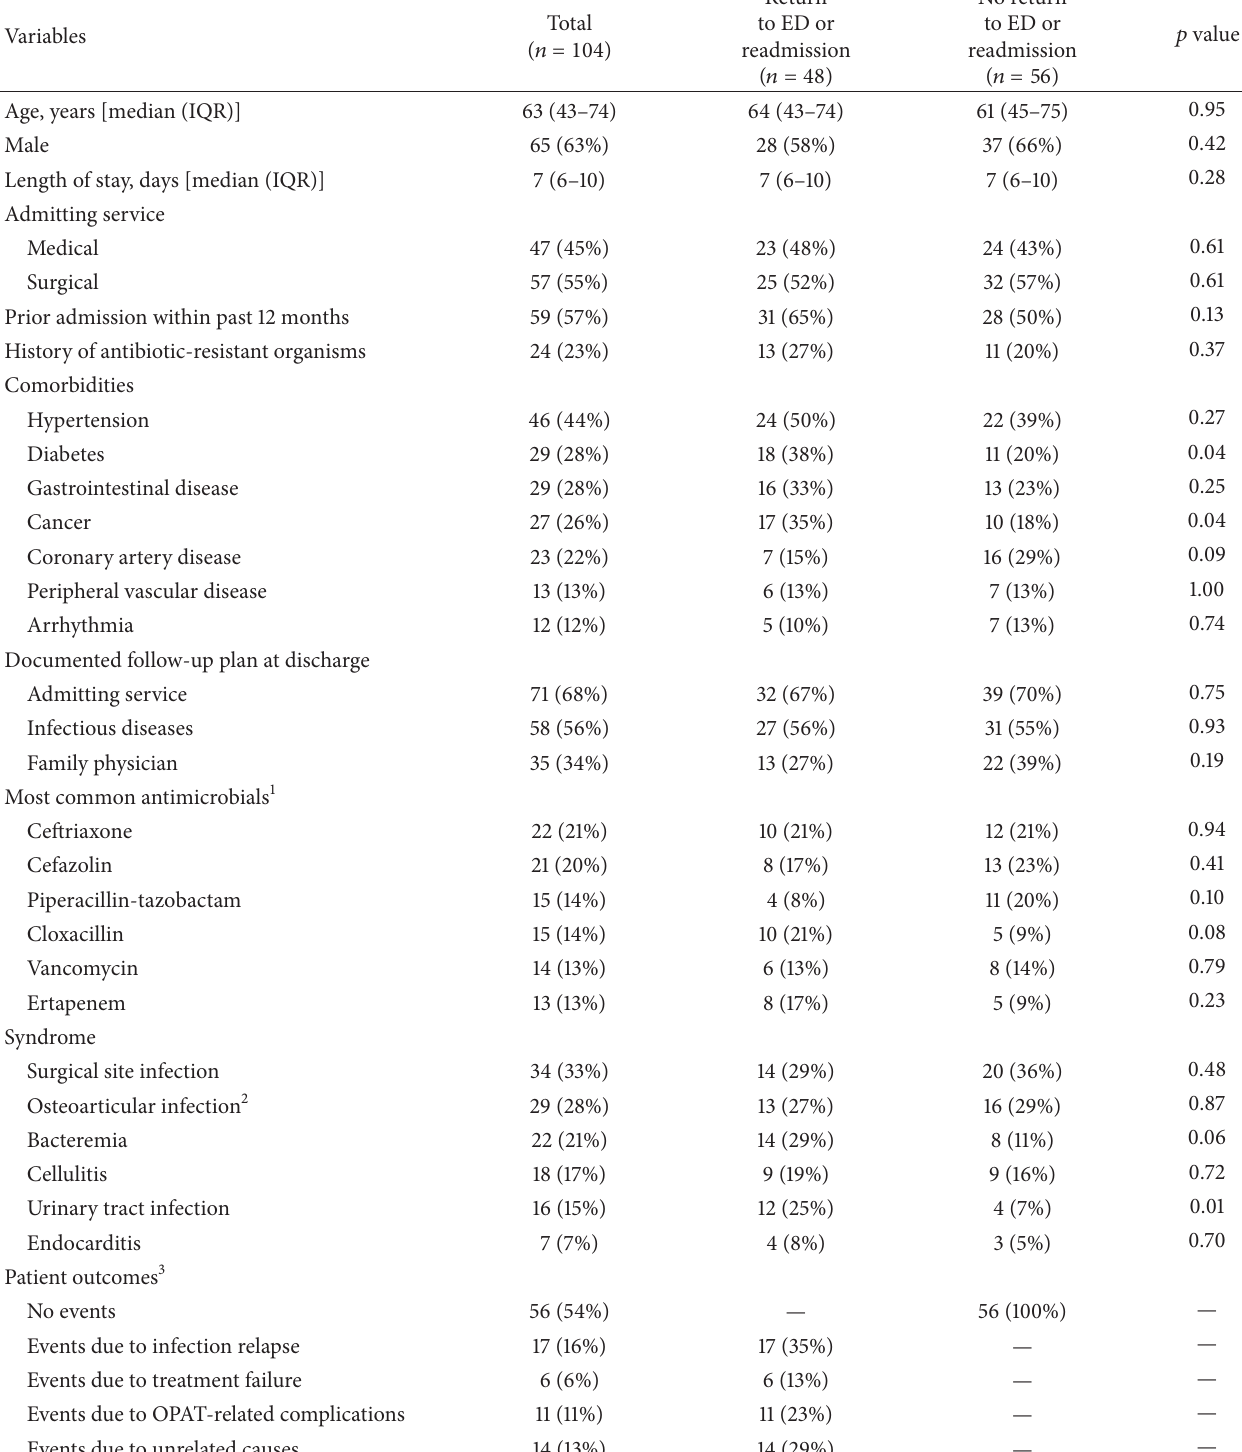
Table 1: OPAT patient characteristics and